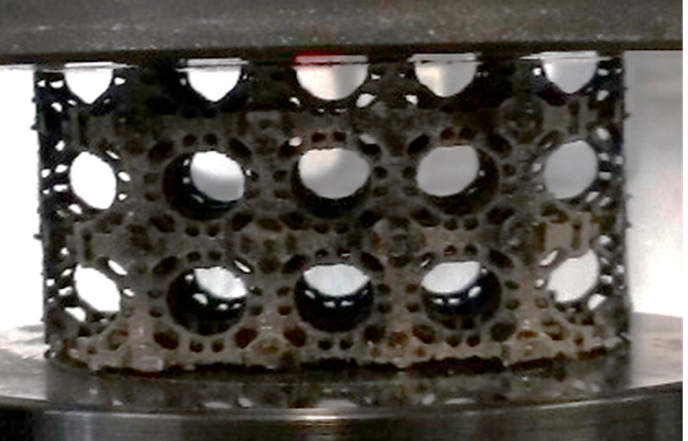
Figure 23. Actual deformation in AUX during compression testing. Note the negative Poisson ratio seen at the edges during compression.